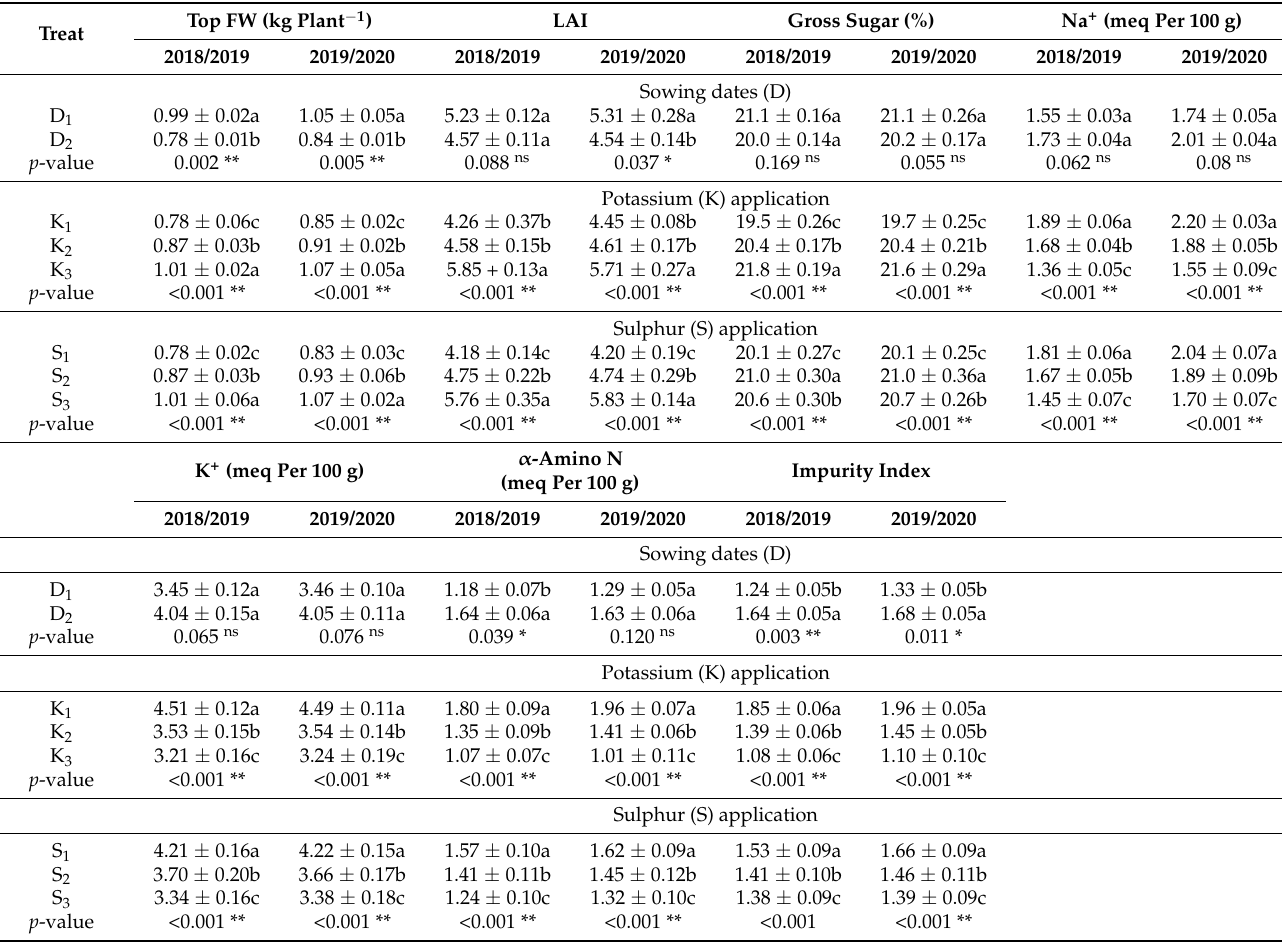
Table 4. Effect of sowing dates and applications of potassium and sulfur level and their interactions on top fresh weight (kg plant − 1 ), leaf area index (LAI), sucrose (%), Na, K, and α -amino N (meq per 100 g) and impurity index of sugar beet during two growing seasons (Mean ± SE) under soil salinity (ECe = 8.96 dS m − 1 ) conditions. Top FW (kg Plant − 1 ) LAI Gross Sugar (%) Na + (meq Per 100 Treat